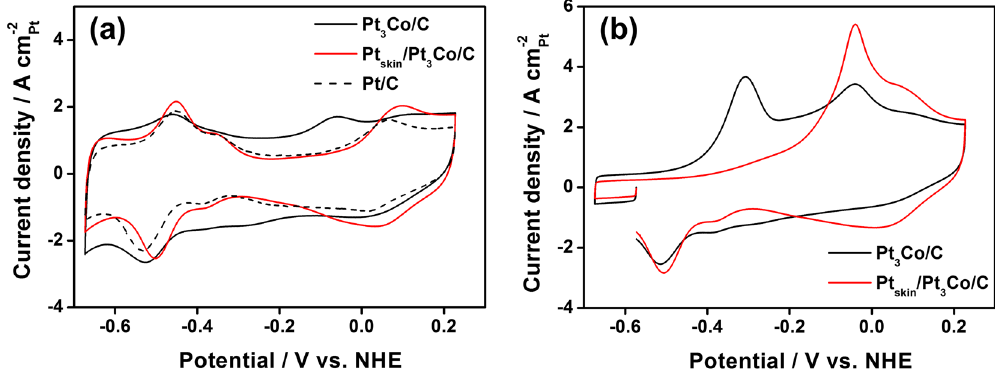
Figure 1. Cyclic voltammograms of the electrocatalysts. ( a ) pristine Pt 3 Co/C, Pt skin /Pt 3 Co/C, and Pt/C in 0.1 M KOH and ( b ) electrochemical oxidation of adsorbed CO on pristine Pt 3 Co/C and Pt skin /Pt 3 Co/C.